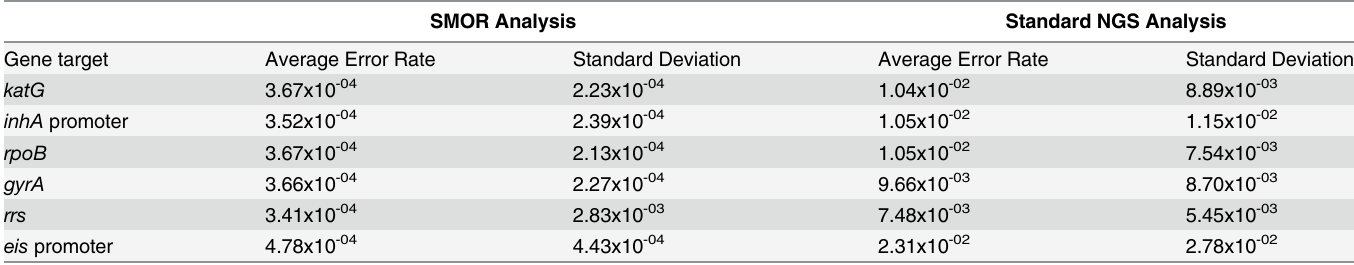
Table 1. Comparison of observed error rate for SMOR analysis versus standard NGS analysis on a pure pan-susceptible Mycobacterium tubercu- losis isolate across the entire